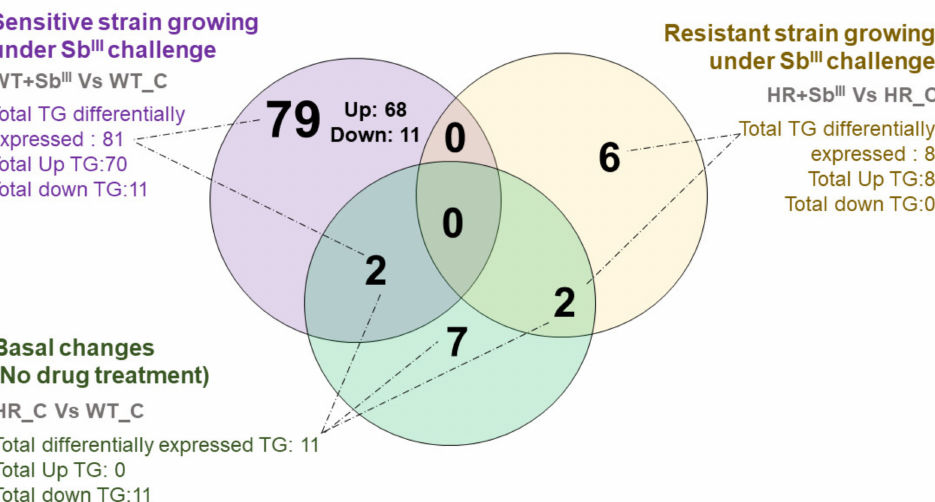
Figure 6. The profile of overexpressed triglycerides (TG) differs completely between antimony sensitive and resistant parasites. The distribution of differentially expressed TGs is represented in a Venn diagram. TGs distribution is plotted by three different comparisons: basal phenotypic changes in resistant strain in the absence of drug in comparison with sensitive (green circle), sensitive strain responding to Sb III (purple circle) and resistant strain responding to Sb III (yellow circle). The number of upregulated and downregulated triglycerides (TG) is represented per comparison.